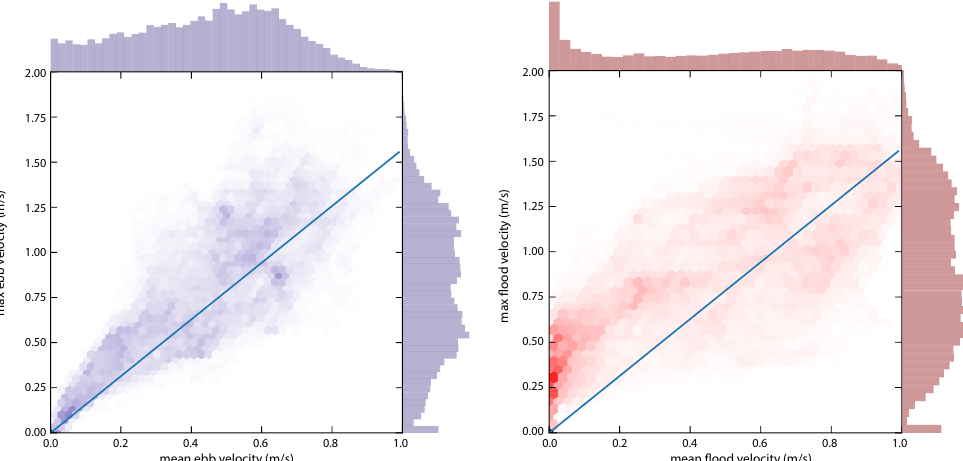
Figure A5. ( Left ) maximum ebb velocity as a function of mean ebb velocity; ( Right ) maximum ebb velocity as a function of mean ebb velocity. Histograms indicate occurrence within bins and colours in the plot become darker with increasing density. Drawn lines indicate the relation x = 2/ π y , which is the expected average velocity when calculated as the average of half a sine function with an amplitude equal to the peak